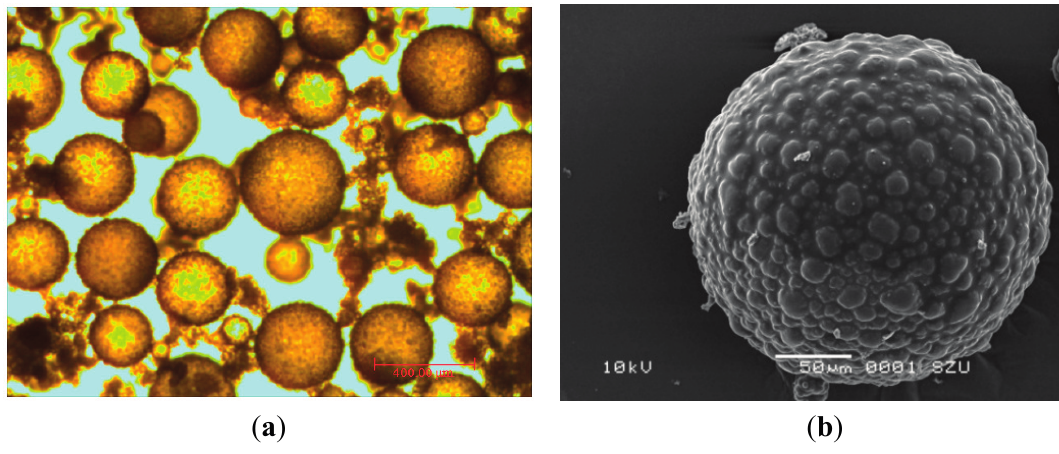
Figure 4. The morphology of manufactured MPCM ( a ) optical microcopy; ( b )